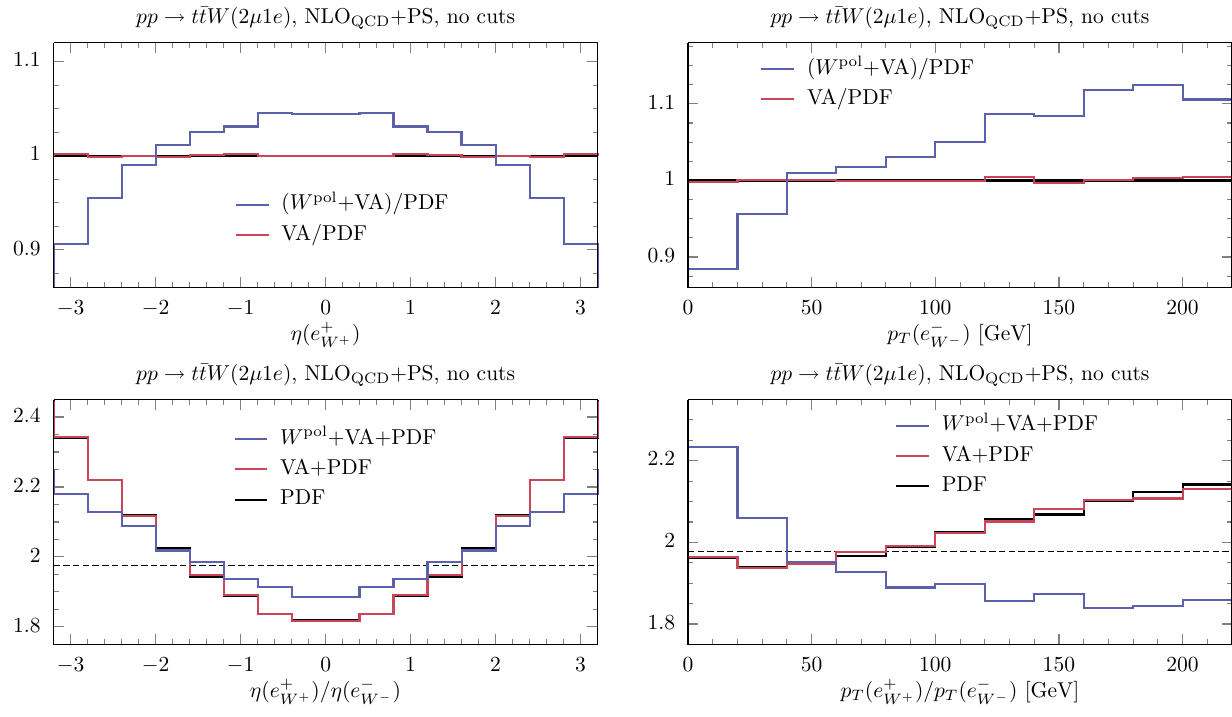
Fig. 2 Origin of asymmetries in W associated decay products. The electrons (positrons) in these plots originate exclusively from the W − ( W + ) associated boson. The sum of these effects (blue line) is included in the modern MC